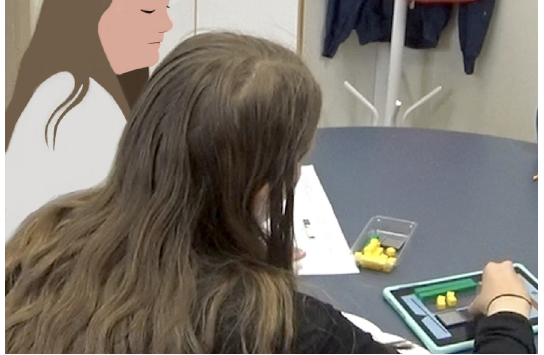
Figure 7. Peer scaffolding. St 15 (A) (in front) showing and telling St 16 (B) (in back) how to solve the